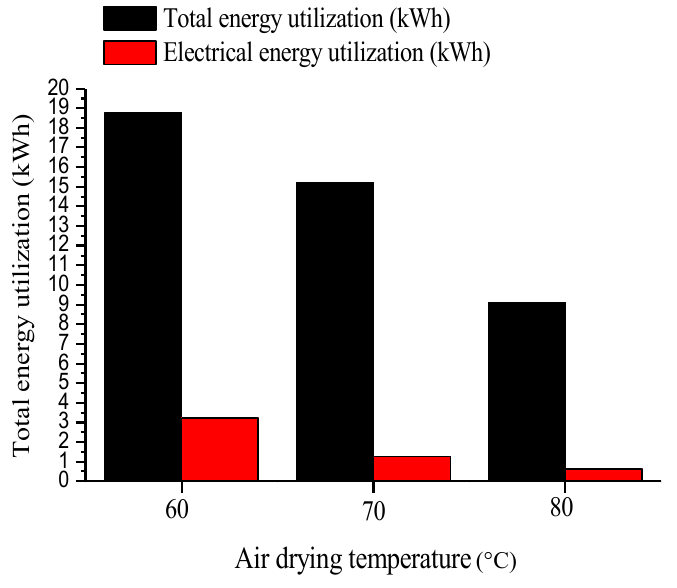
Figure 9. Total electrical energy used in drying the Arbutus unedo L. fruits. The total energy consumption decreased as the temperature increased (Figure 9).